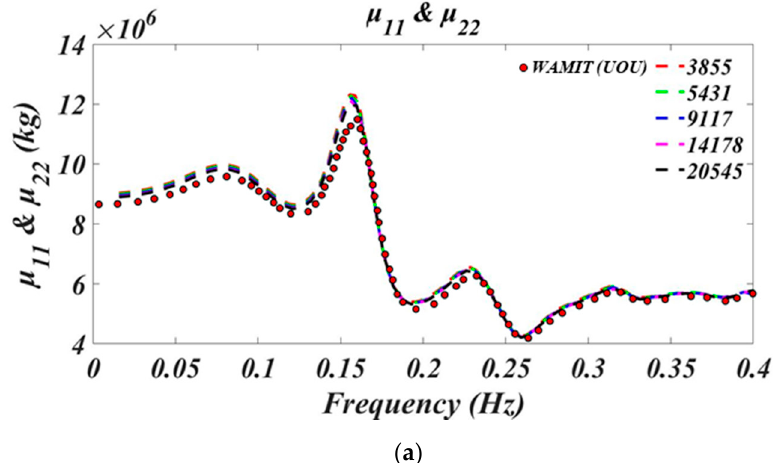
( a ) ( a ) Figure 8. Cont